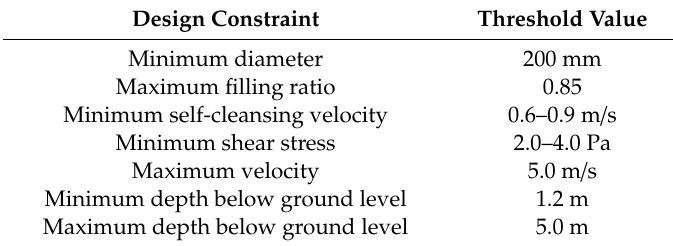
Table 2. Hydraulic design constraints modified from Duque et al.